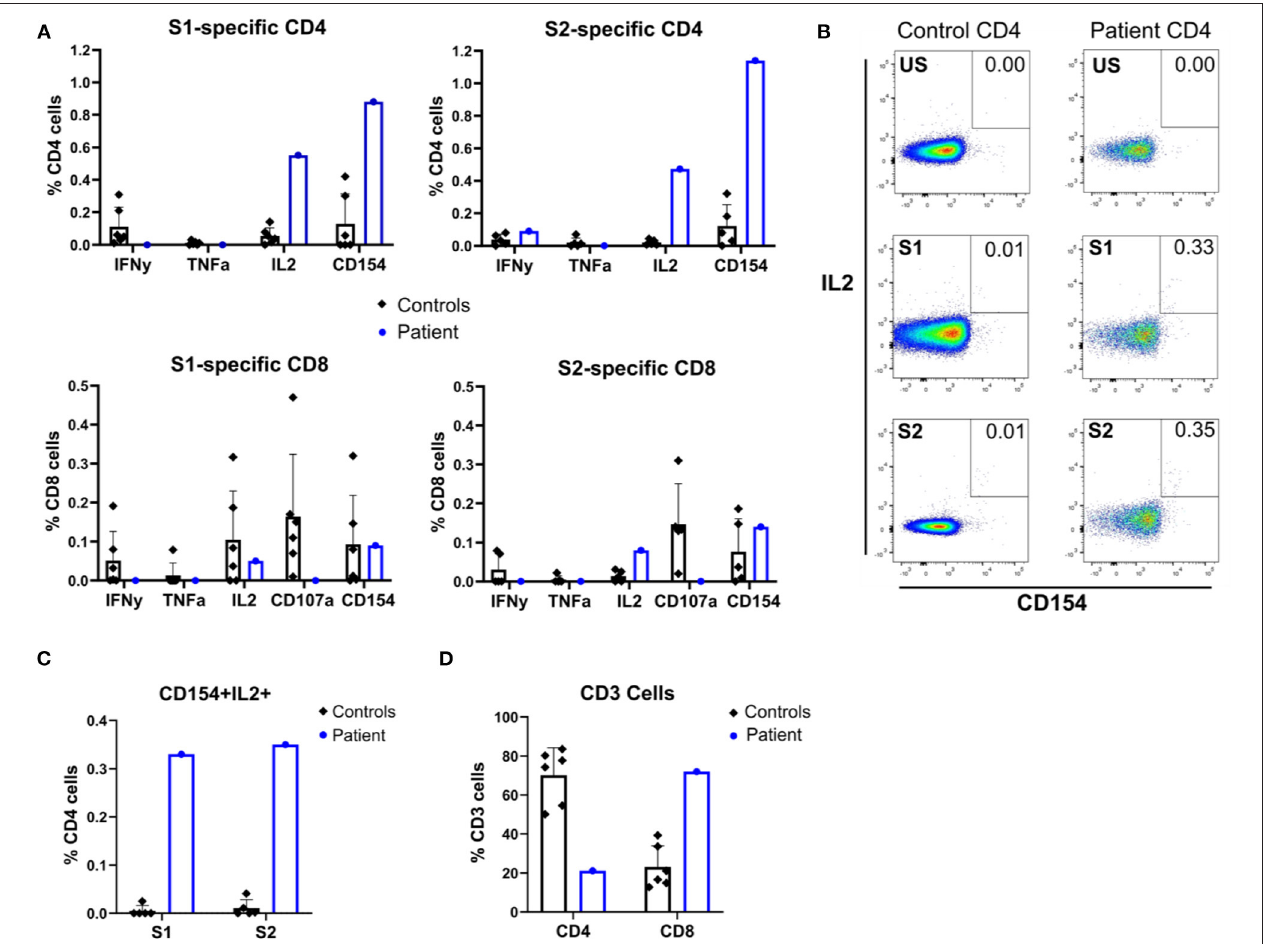
FIGURE 3 | Flow cytometric immunophenotyping reveals SARS-CoV-2 peptide-specific responses of patient and seropositive control T cells. (A) Patient and control seropositive PBMCs were stimulated with SARS-CoV-2 S1 or S2 peptide pools before flow cytometric assessment for induction of cytokines (IFN γ , TNF α , and IL-2) and surface markers of activation (CD154 and CD107a). (B) Representative flow cytometry dot plots showing expression of CD154 and IL-2 by stimulated patient or control PBMC, gated on CD4 + T cells. US, unstimulated; S1, spike protein 1; S2, spike protein 2. (C) Quantification of double-positive CD154 + IL2 + CD4 cells after stimulation with spike peptide pools S1 and S2. (D) CD4 and CD8 cell